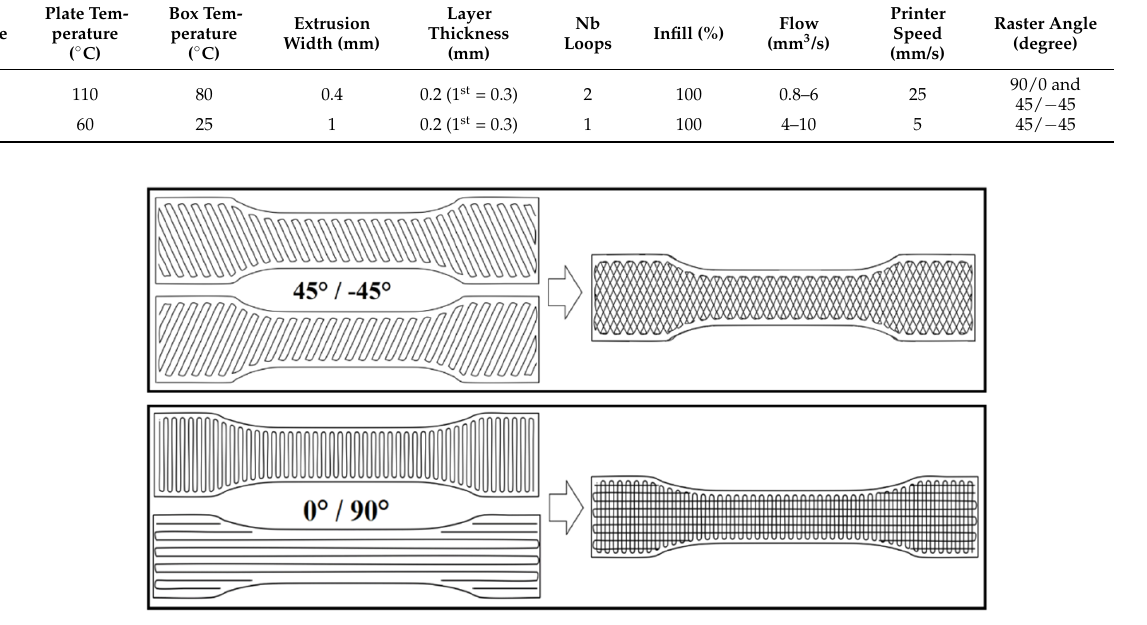
Table 2. Main printing parameters used for the preparation of the 3D printed specimens.